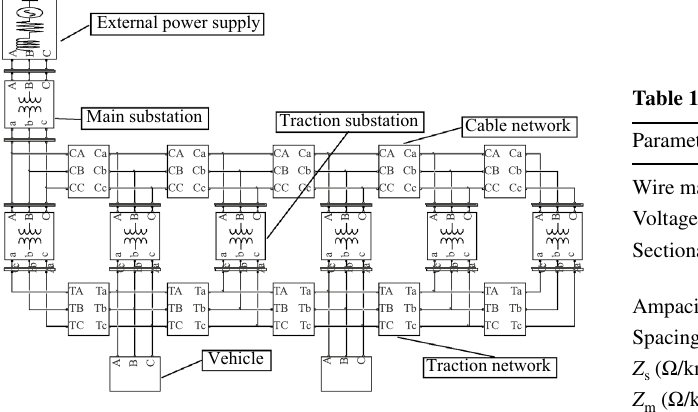
Fig. 9 Simulation model of three-phase traction system